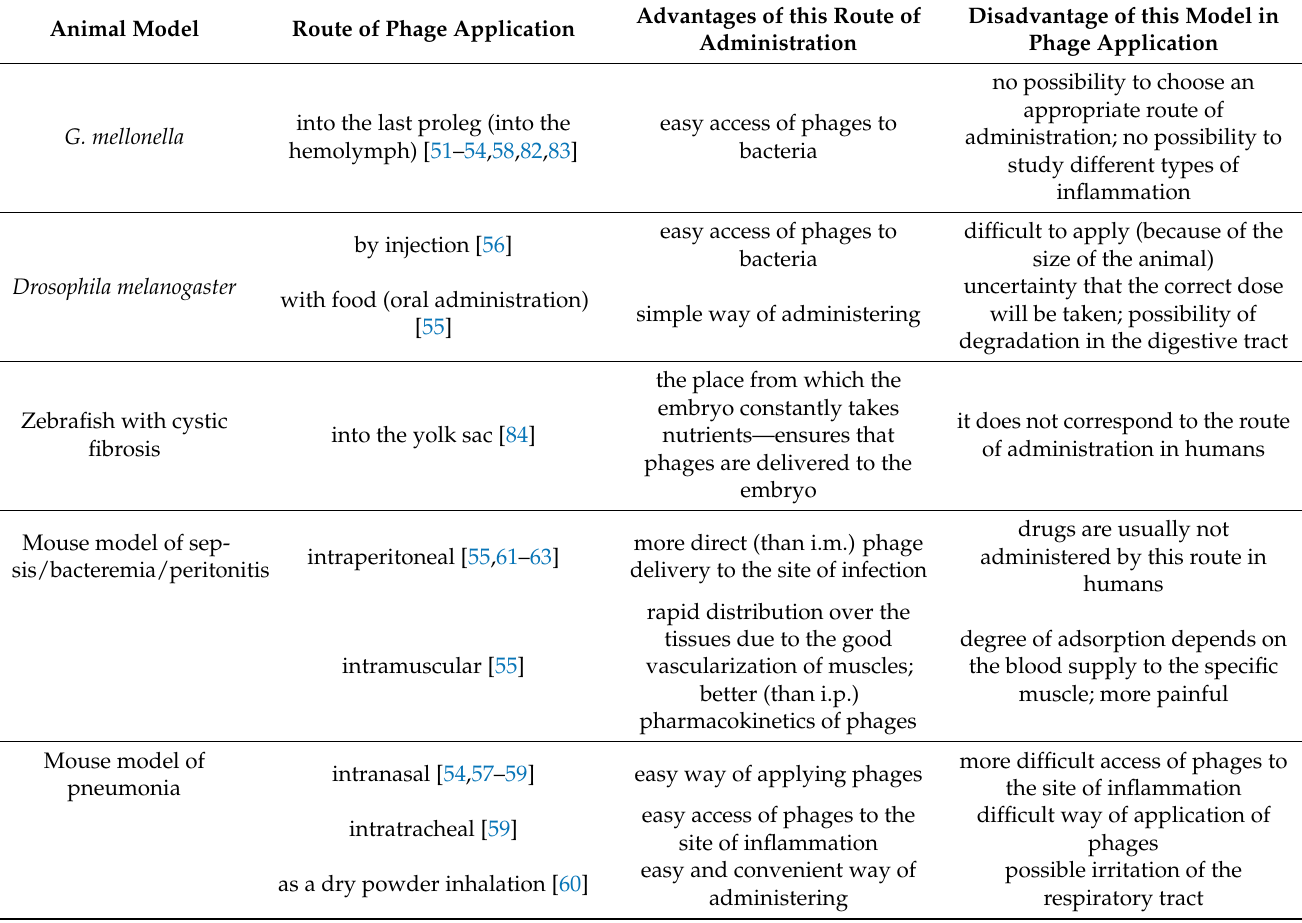
Table 1. Different routes of phage administration in selected animal models infected with bacteria from the ESKAPE group, their advantages and limitations. Animal